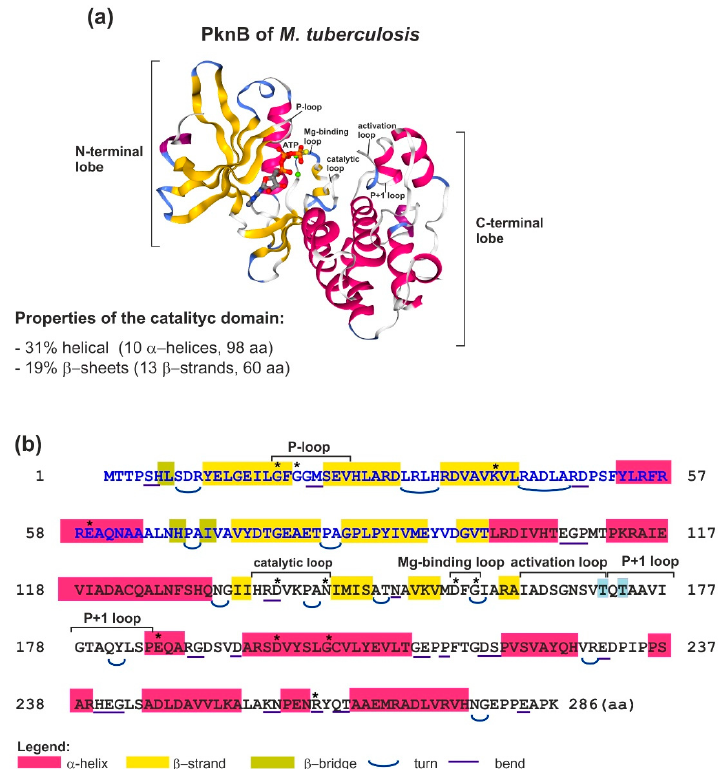
Figure 1. Structure of the catalytic domain of Mycobacterium tuberculosis STK PknB. ( a ) Crystal structure of the PknB catalytic domain with an ATP molecule (Protein Data Bank (PDB) accession number 1MRU) [117]. N-terminal and C-terminal lobes as well as individual loops are indicated. α -Helices are shown in pink, β -sheets are in yellow, ATP molecule is shown in red and grey, and Mg 2+ ions are shown as green spheres. ( b ) Primary amino acid sequence of the 286-residue catalytic domain of PknB. The amino acids (aa) of the N-terminal lobe are blue and aa of the C-terminal lobe are black. Conserved motifs are marked with square brackets, invariant residues are denoted by asterisks, and the phosphorylated Tyr residues in the activation and P+1 loops are shaded in